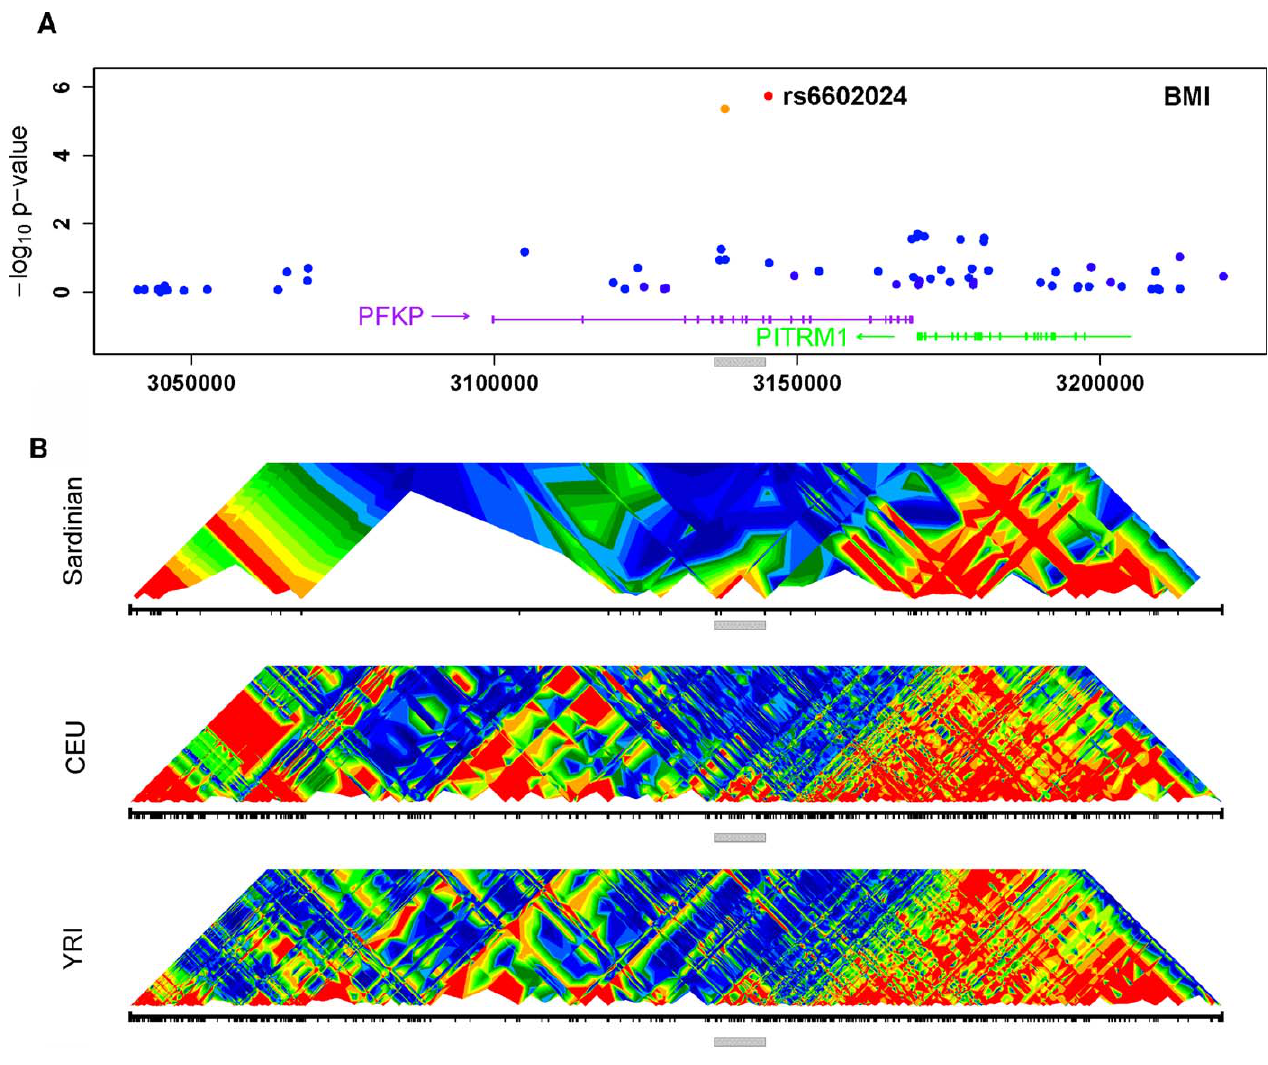
Figure 3. Association Results and LD Patterns in Region Surrounding the PFKP Gene (A) Summary of the association between SNPs in the region and BMI. The SNP showing strongest association (rs6602024) is highlighted. Other SNPs are colored according to their degree of disequilibrium with rs6602024, ranging from high (orange) to low (blue). Transcripts are indicated at the bottom of the graph, with an arrow indicating transcript direction. (B) Summary of the patterns of disequilibrium in the region in Sardinia and in two of the HapMap populations (CEU and YRI) [55]. The grey bar marks the region of association and facilitates comparisons between the panels.